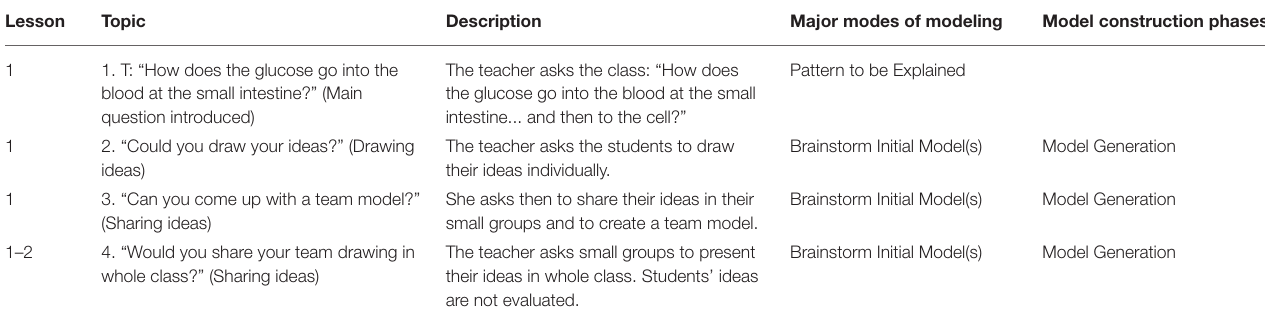
TABLE 3 | Pattern to be explained mode, and brainstorming initial models mode (Part 1).